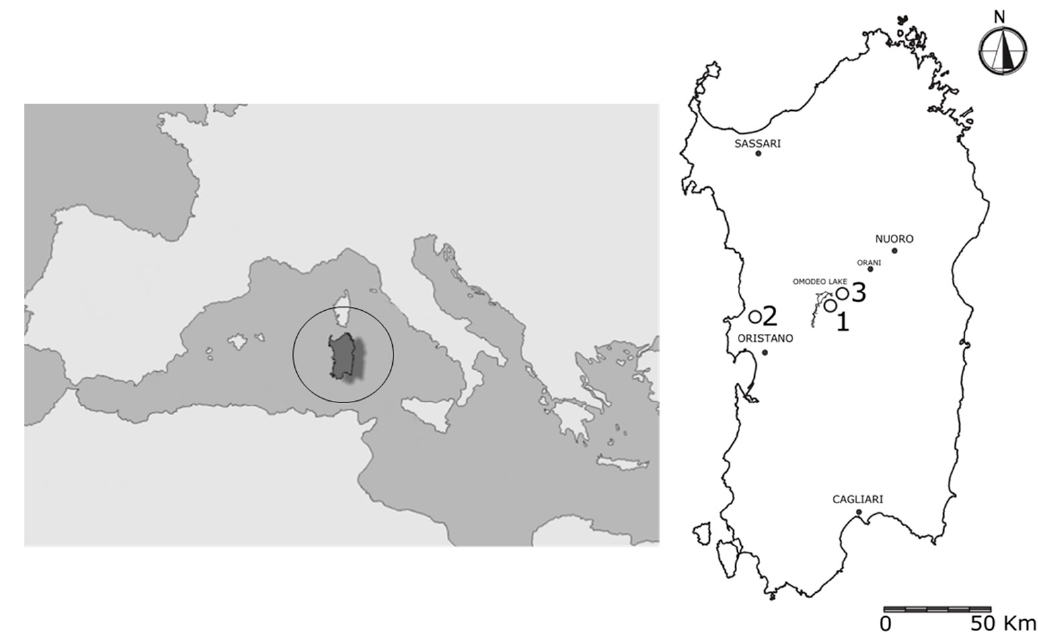
Figure 1. Sketch map of Sardinia and location of archaeological sites. 1—Santu Perdu; 2—Narbolia; 3—Sorradile.